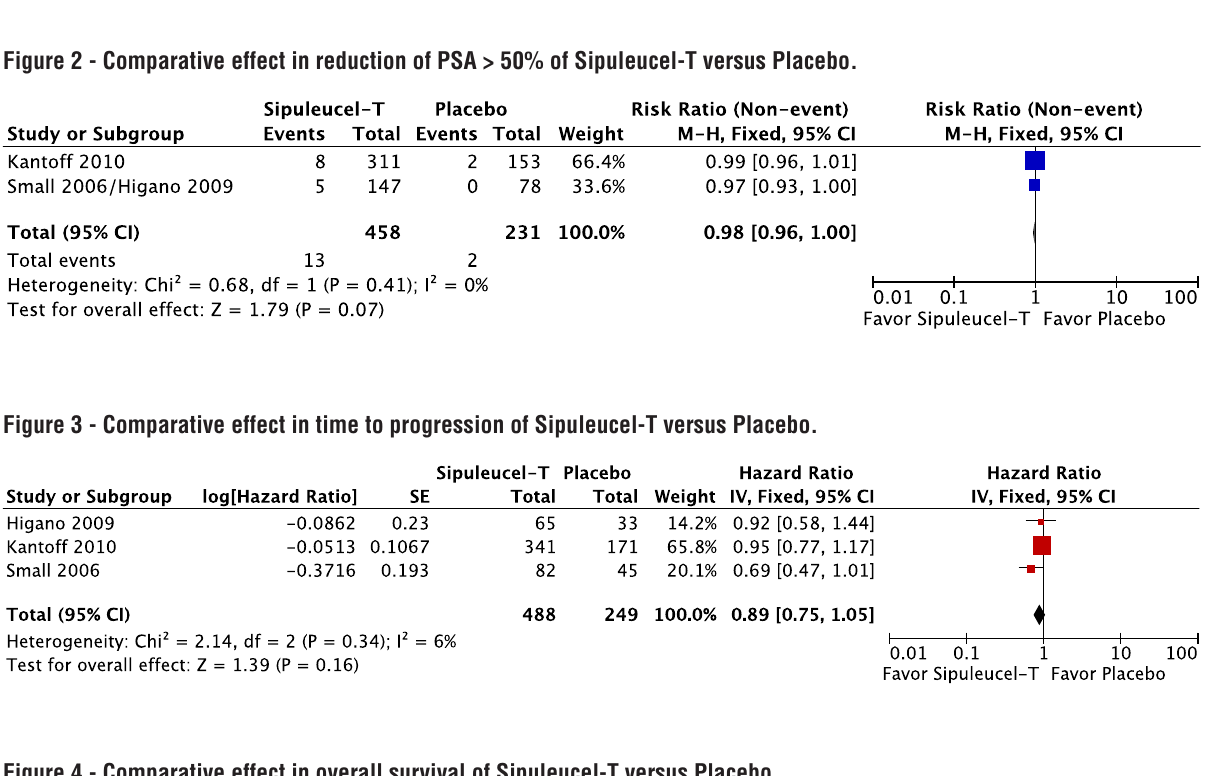
Figure 4 - Comparative effect in overall survival of Sipuleucel-T versus